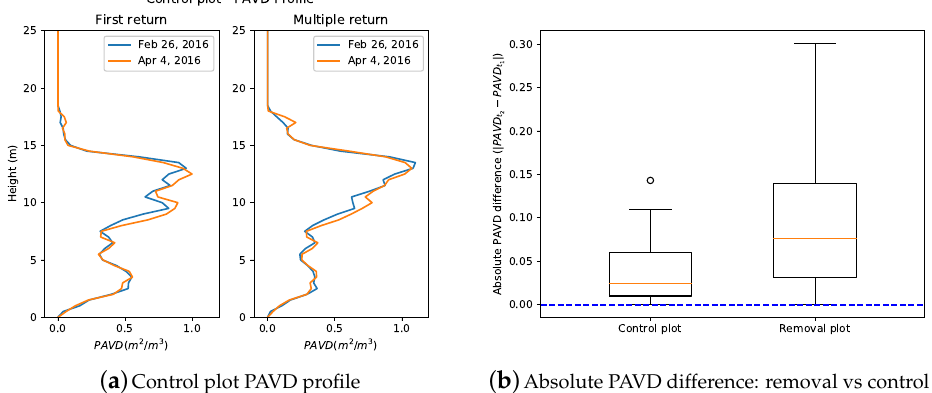
( a ) Control plot PAVD profile ( b ) Absolute PAVD difference: removal vs control plot Figure 8. ( a ) shows the bi-temporal Plant Area Volume Density (PAVD) profiles of the control plot and ( b ) shows the absolute PAVD difference box plot of the control and removal plot, with t 2 being the data from second time step and t 1 , the first time step.